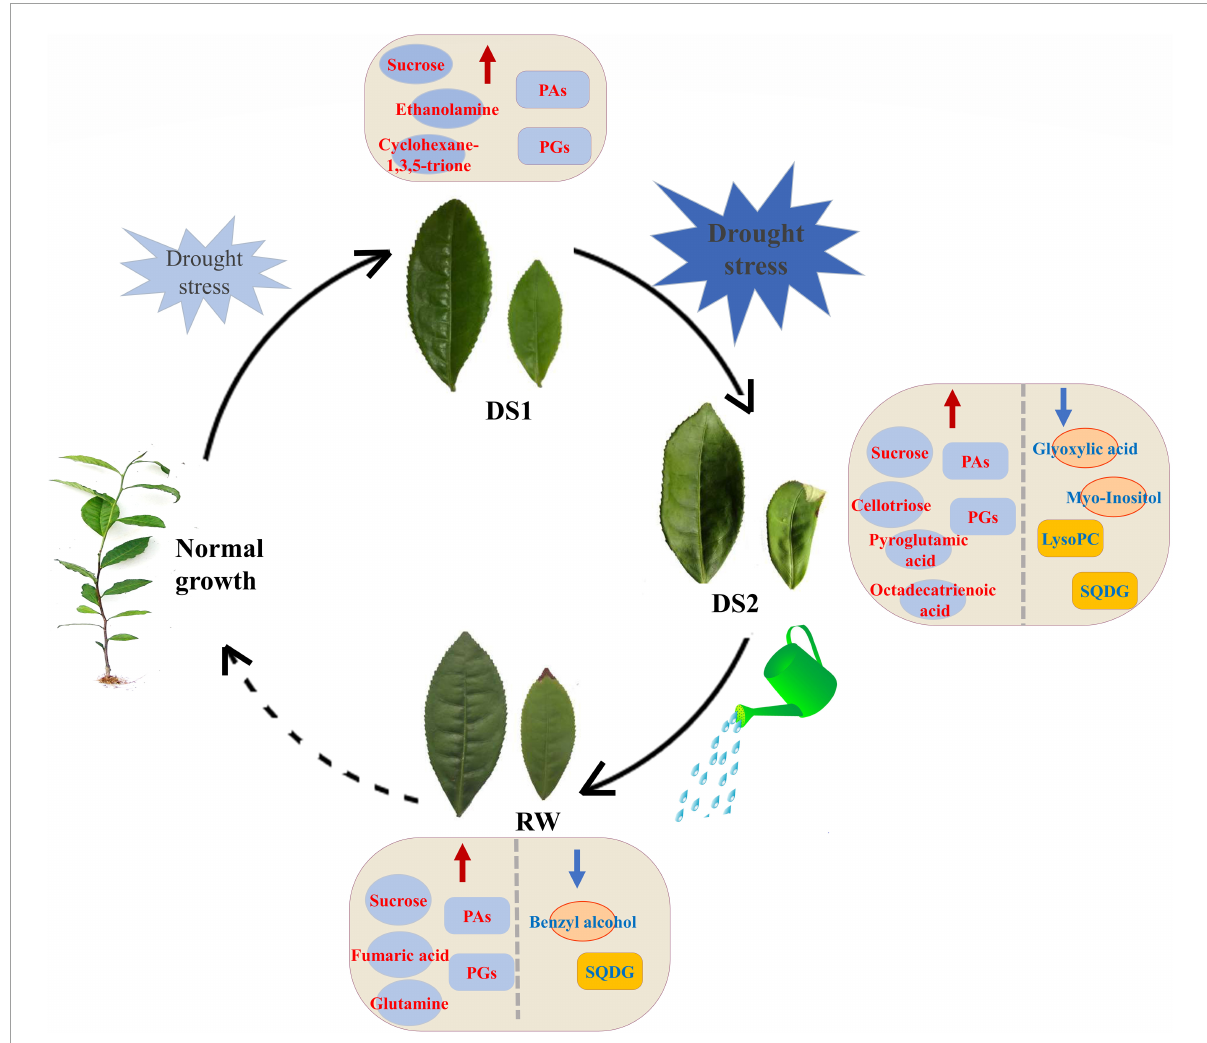
FIGURE8 Models of possible mechanisms of tea plants responding to different water conditions. The red and blue arrows indicated that the levels of metabolites increased and decreased,